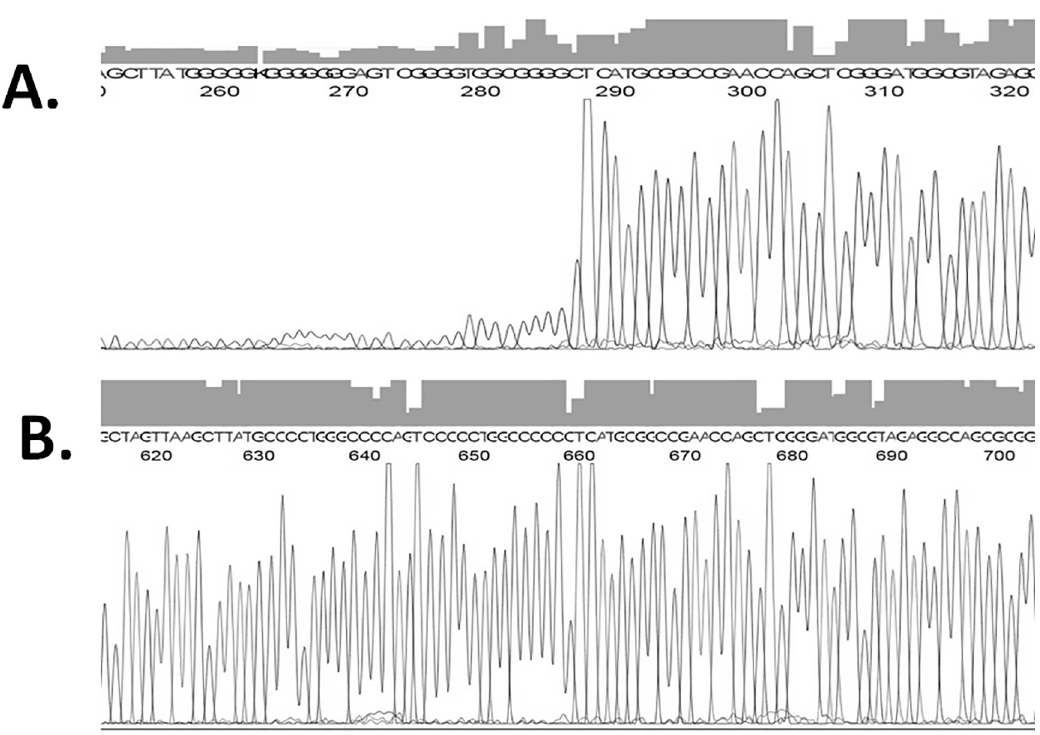
Fig 6. Mapping of G-quadruplex site by Sanger sequencing. Sequencing of IGFN1-wild (A) and IGFN1-mutant (B) plasmid in presence of 2 μ M PDS.